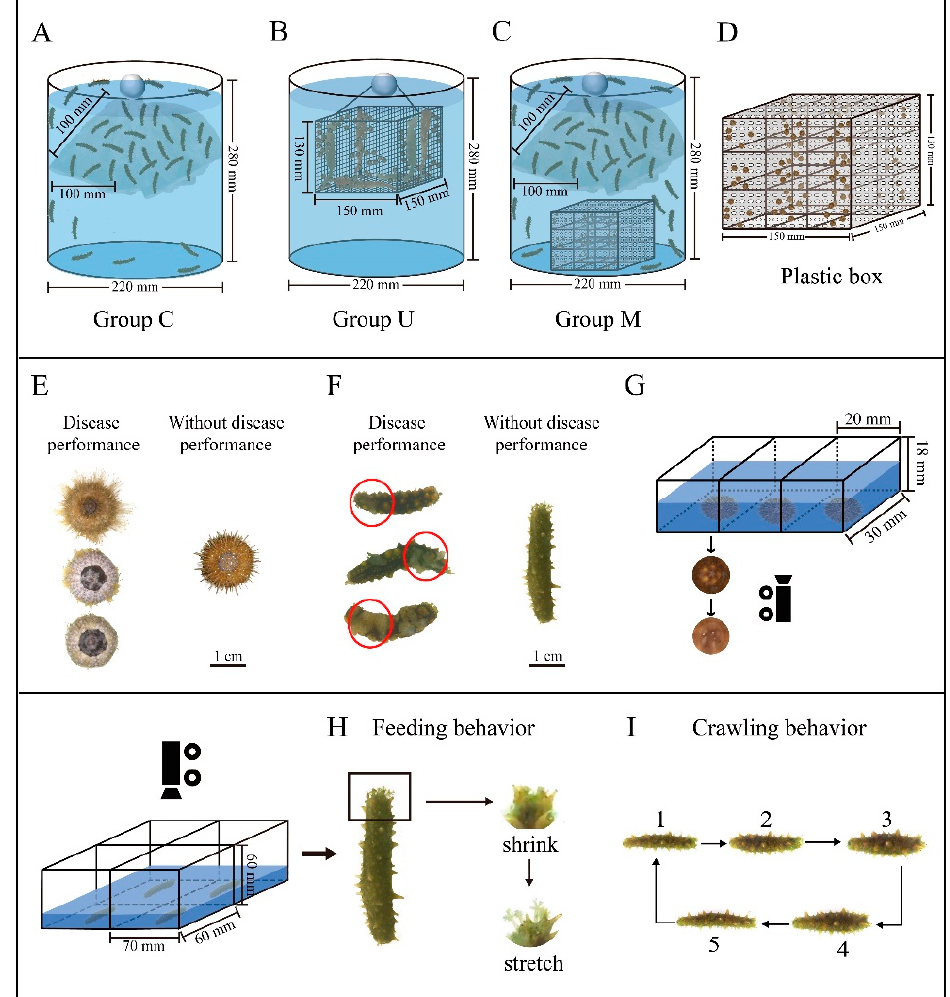
Figure 1. Experimental facilities used for group C ( A ), group U ( B ), and group M ( C ). Group C: the control group for sea cucumbers. Group U: the control group for sea urchins. Group M: the integrated multi-trophic aquaculture of sea cucumbers and sea urchins. A dismountable plastic box divided into three layers and six compartments in each layer was used to culture sea urchins in group M ( D ). Sea urchins with the performance of black-mouth disease and without the disease performance ( E ). Sea cucumbers with the performance of skin ulceration syndrome and without the disease performance ( F ). Red circles indicate the ulcerative skin in sea cucumbers ( F ). Aristotle’s lantern reflex of sea urchin ( G ). Feeding behavior of sea cucumbers refers to the process, by which the tentacles reach the food sediments and deliver them to the mouth ( H ). Crawling behavior indicates the movement ability of sea cucumbers, and it was divided into five stages ( I